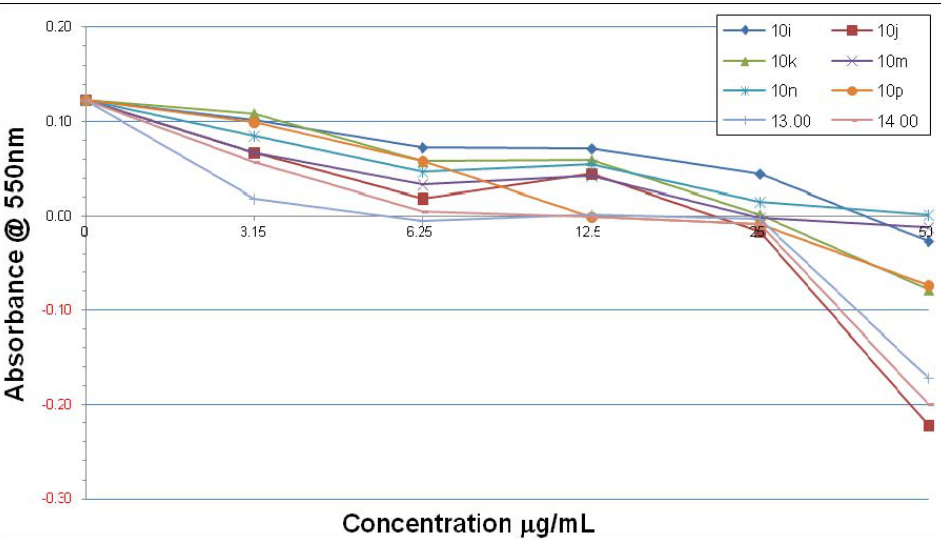
Figure 2. Inhibitory effects of compounds 10i – p , 13 and 14 on H. pylori 3339 after 7